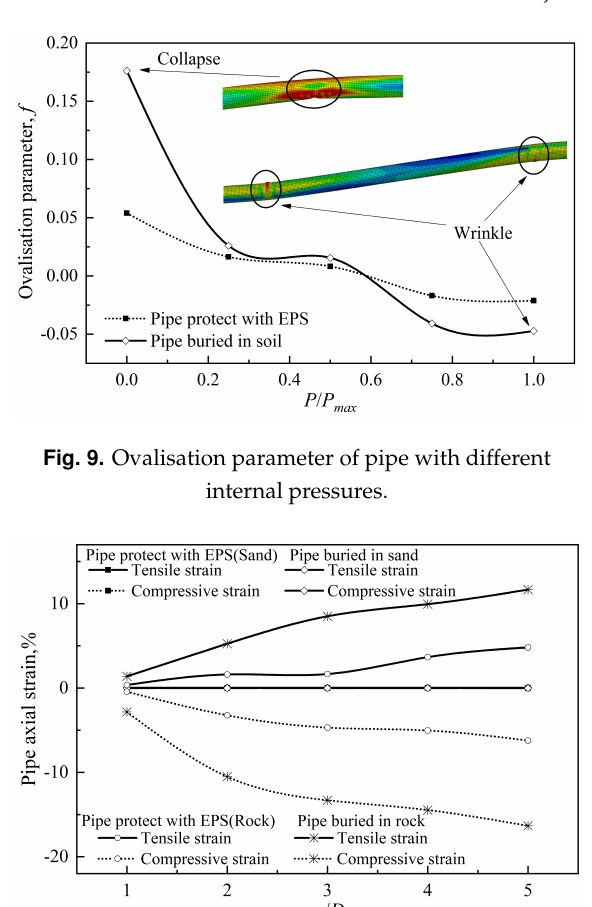
Fig. 10. Max tensile strain of buried pipe in different soils.